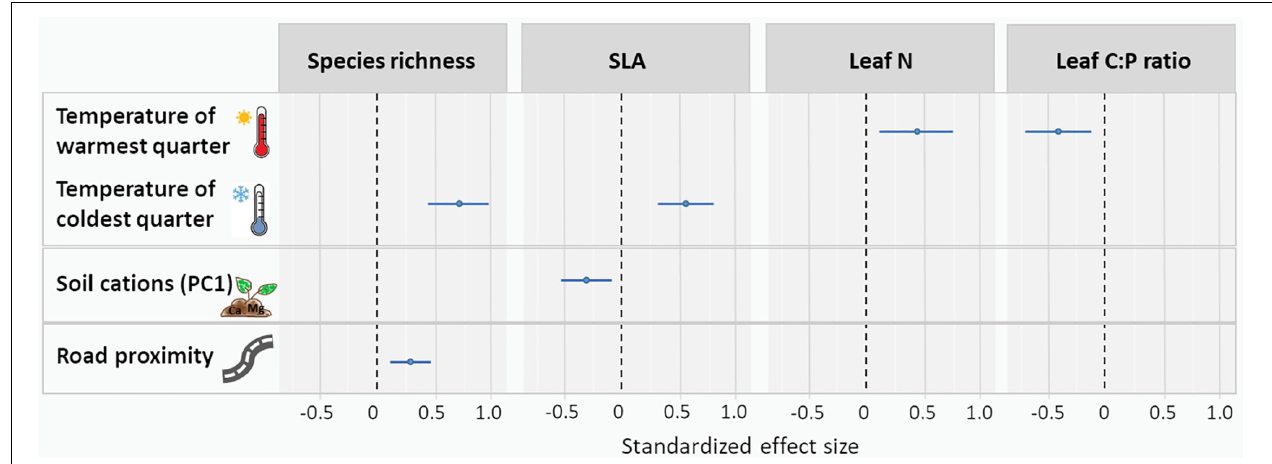
FIGURE 4 | Standardized effect size of mean temperature of warmest quarter, mean temperature of coldest quarter, soil cations (summarized through the first axis of the PCA) and road proximity on CWMs of plant functional traits (SLA [mm 2 mg − 1 ], leaf N [%], and leaf C:P [g g − 1 ]) and species richness. Only significant effects are shown. For complete results, see Supplementary Table 3